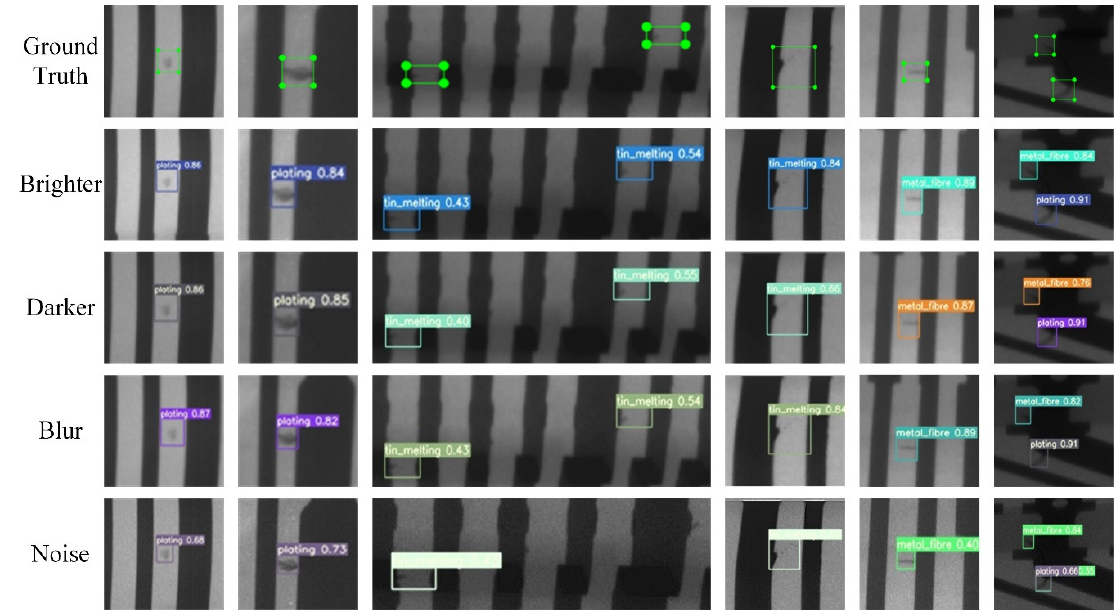
Figure 17. The DR image defect detection under different interference. Brighter (l = 0.2), darkened (l = 0.8), blur ( η = 0.2), salt and pepper noise ( σ = 0.02).